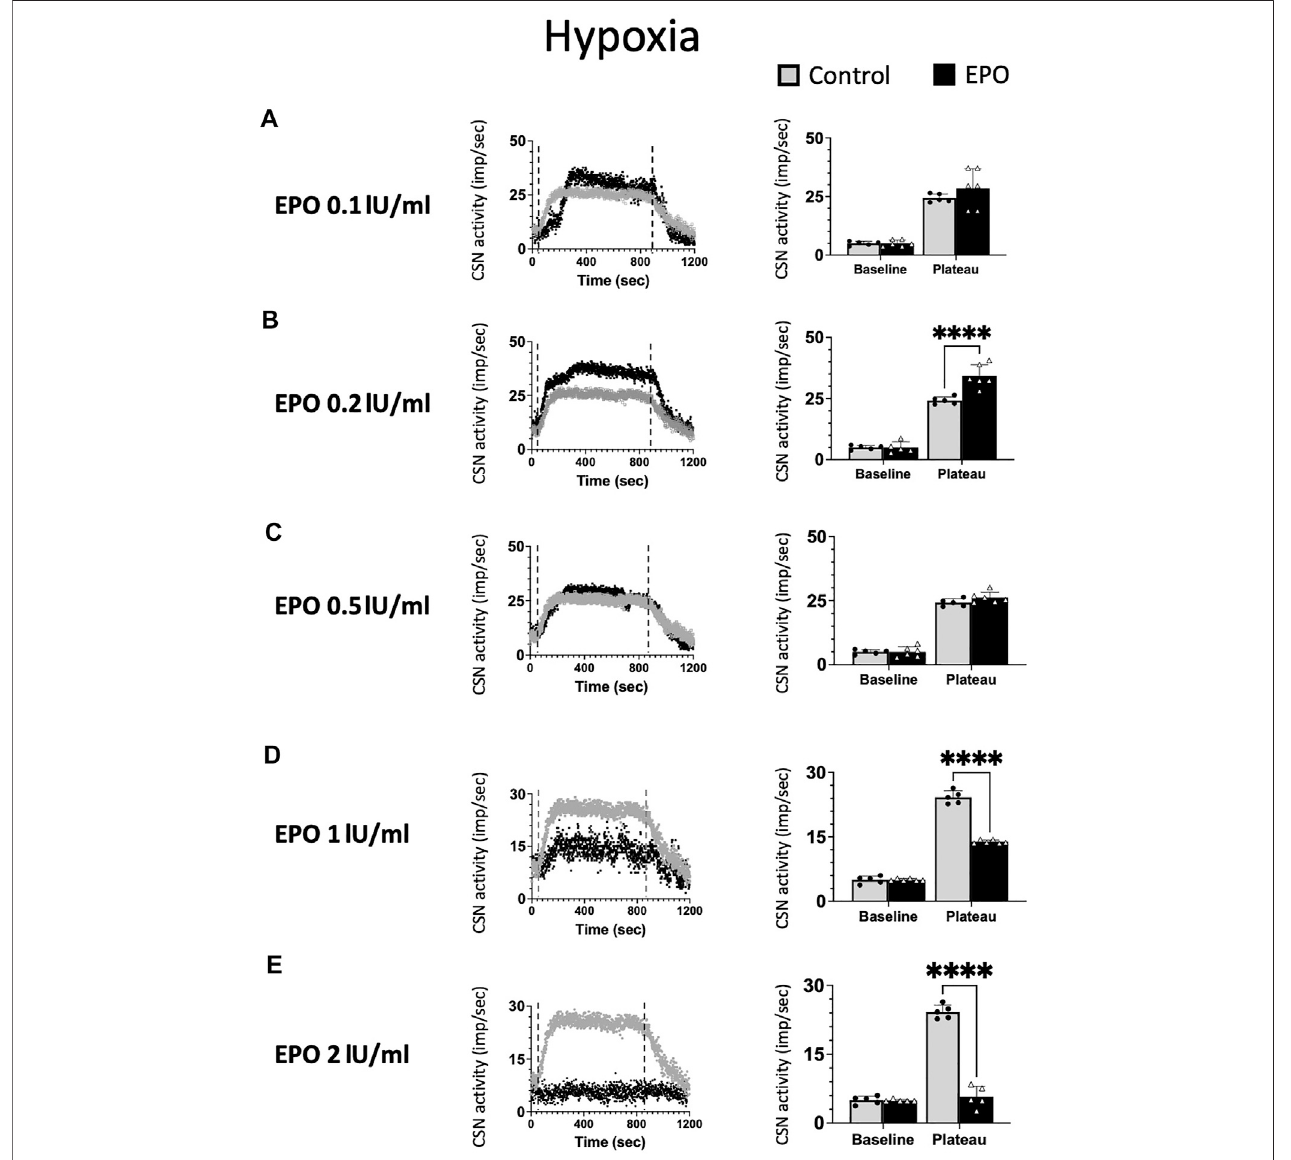
FIGURE2| Erythropoietin (EPO) induces dose-dependent carotid sinus nerve (CSN) activity under hypoxic conditions. EPO at a concentration of 0.2 IU/ml signi fi cantly increases the activity of CSN (RM Two-way ANOVA F (1, 8) (cid:1) 28.6 p (cid:1) 0.0007) (B) , while there was no difference between the control and EPO at a concentration of 0.1 IU/ml (RM Two-way ANOVA F (1, 9) (cid:1) 1.47 p (cid:1) 0.256) (A) nor 0.5 U/ml (RM Two-way ANOVA F (1, 9) (cid:1) 2.04 p (cid:1) 0.187) (C) . Erythropoietin (EPO) at a concentration of 1 IU/ml leads to a strong inhibition of CSN activity (RM Two-way ANOVA F (1, 9) (cid:1) 189 p < 0.0001) (D) and 2 IU/ml supress the activity of the carotid sinus nerve (CSN - RM Two-way ANOVA F (1, 8) (cid:1) 199 p < 0.0001) (E) . Dashed lines indicate the beginning and end of the hypoxic stimulus. ****: p < 0.0001.